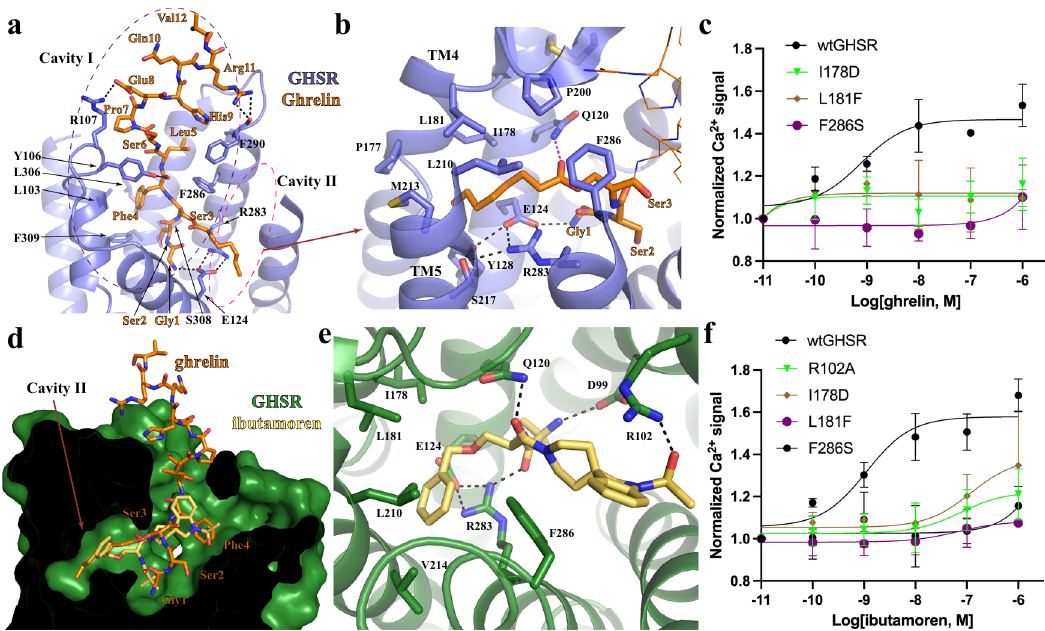
Fig. 2 Binding pockets for ghrelin and ibutamoren. a Ghrelin binding in the cavity I and II. Ghrelin residues are labeled in orange. GHSR is colored in slate. b Binding of the octanoyl group of ghrelin in the cavity II. c Dose-dependent action of ghrelin on the wild type GHSR (wtGHSR) and mutants. d Alignment of ghrelin and ibutamoren. GHSR bound to ibutamoren is colored green. Ibutamoren is shown as yellow sticks. e Ibutamoren binding pocket. f Dose- dependent action of ibutamoren on wtGHSR and mutants. In c and f , agonist-induced GHSR signaling was measured by Ca 2 + mobilization assay. Each data point represents mean ± S.D. from three independent assays. Polar interactions are shown as dashed lines in ( a , b , and e